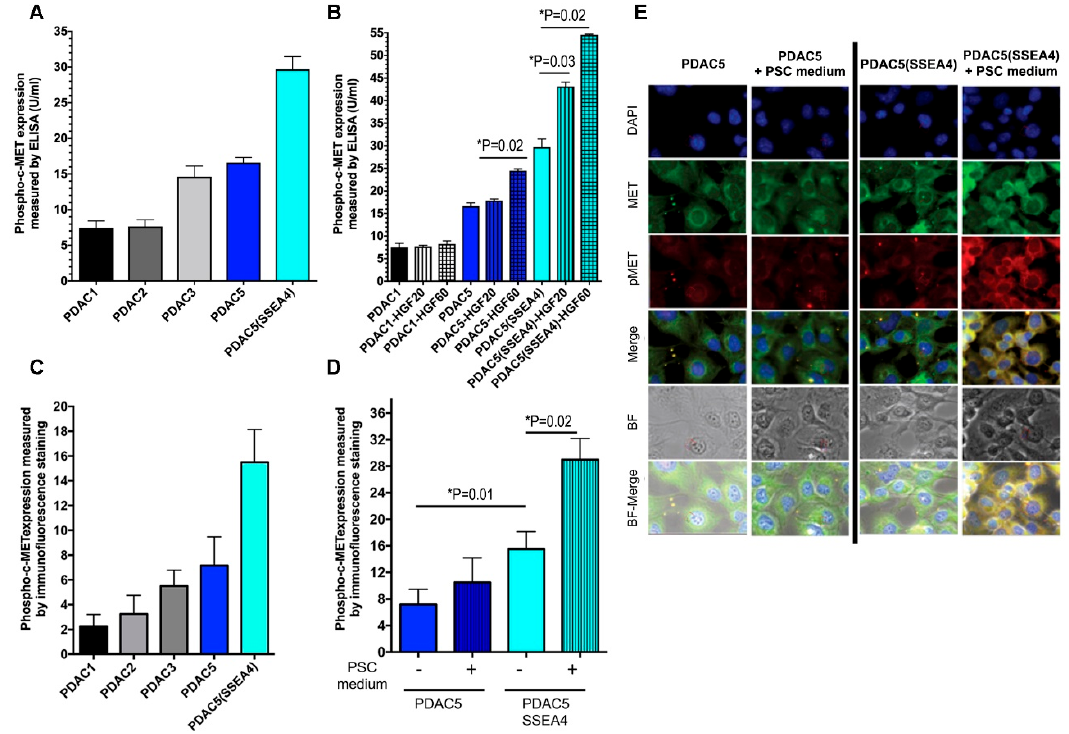
Figure 1. Expression of phospho-c-MET in human primary pancreatic ductal adenocarcinoma (PDAC) cells. Human primary PDAC cells isolated from PDAC patients (PDAC1, 2, 3, 5 and PDAC5 (SSEA4)) were grown in six-well plates for 24 h. Total proteins were extracted from PDAC cells and subjected to analysis by ELISA specific for phosphorylated tyrosine residues 1230, 1234, and 1235 ( A ). PDAC1, PDAC5 and PDAC5 (SSEA4) cells were seeded in six-well plates. After 24 h of incubation, HGF was added at 20 and 60 pg / mL and the cells were further incubated for 24 h. Total protein was extracted and phospho-c-MET levels were measured by the same ELISA kit as described above ( B ). PDAC cells were seeded in 8-chamber slides and after being incubated with PSC conditioned medium for 24 h, were fixed and stained with specific monoclonal rabbit anti-human c-MET and anti-phospho-Y1003-c-MET antibodies (1:200 dilution; Santa Cruz Biotechnology, Dallas, TX, USA). Quantification of immunofluorescence stainings of baseline phospho-c-MET expression ( C ) and